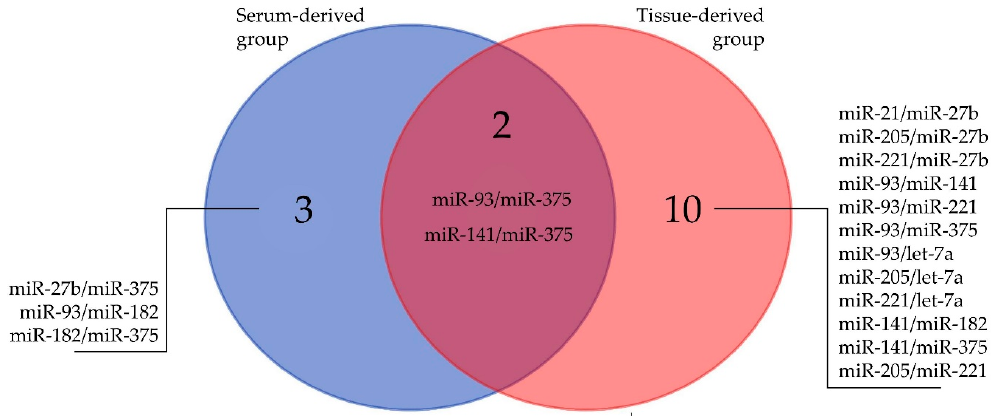
Figure 1. A Venn diagram of the common miRNAs correlations between serum- and tissue-derived Figure 1 . A Venn diagram of the common miRNAs correlations between serum ‐ and tissue ‐ derived groups (for details see Table groups (for details see Table S2).